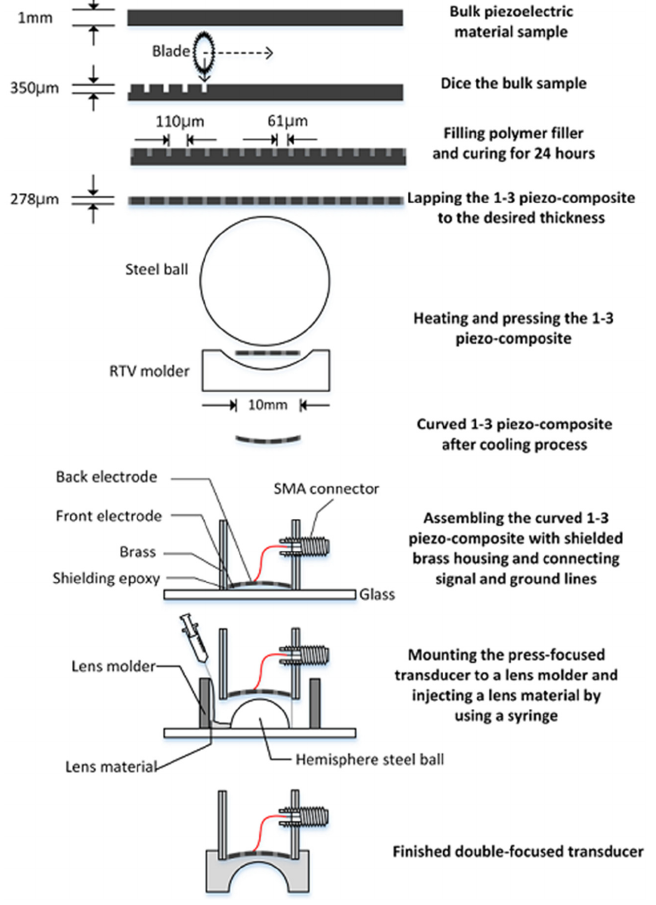
Figure 6. Illustration of the step-by-step fabrication process for a double-focused transducer.